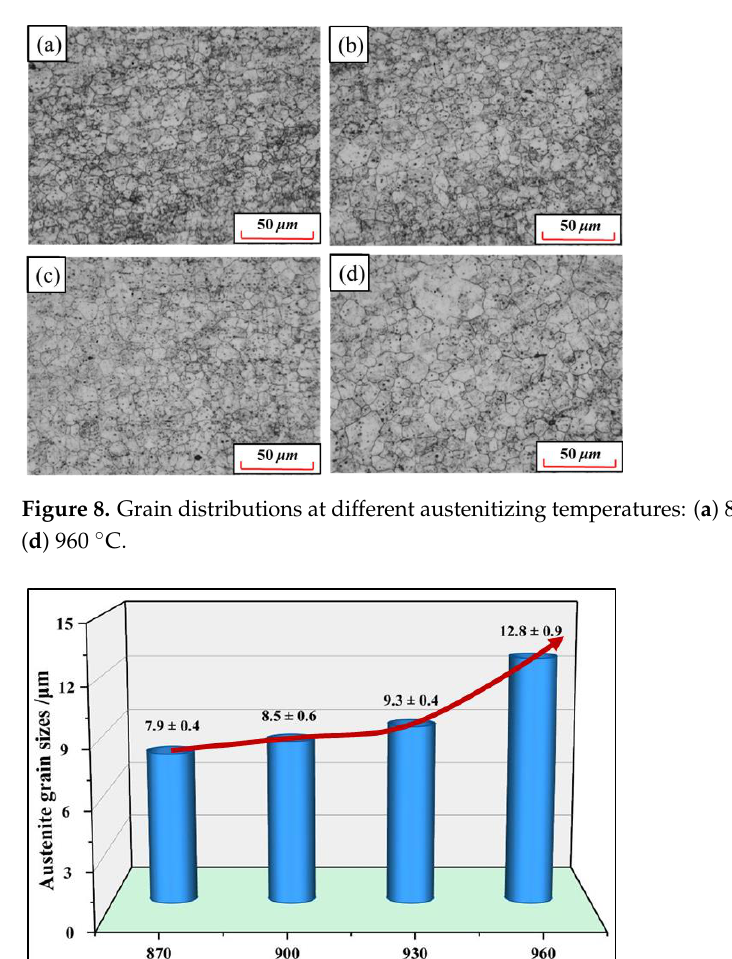
Figure 10. The strength, elongation and UTS × TE variations at different austenitizing tempera- tures. The elongation of 22MnB5NbV decreases with the increase in the austenitizing tem- perature. The highest elongation is 17.6% at 780 °C, which is nearly 10.0% lower than the original steel ’ s elongation at 27.4%. This is due to the transformation of some pearlite and ferrite into austenite in the austenitizing process, and then the transformation of austenite